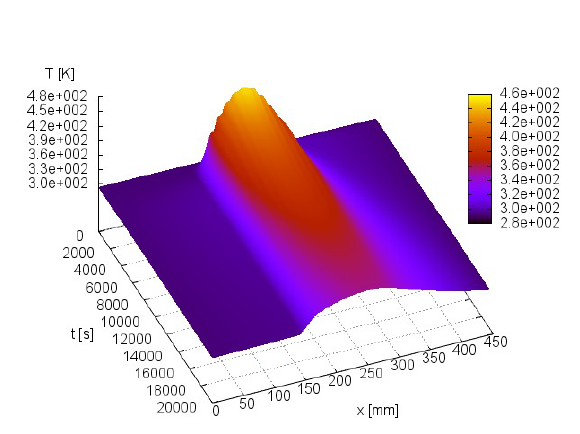
Figure 5. Temperature evolution in Case 1 with k eff = 0 . 282601 (the temperature decreases with time evolution – the nuclear system is brought into safe- conditions).